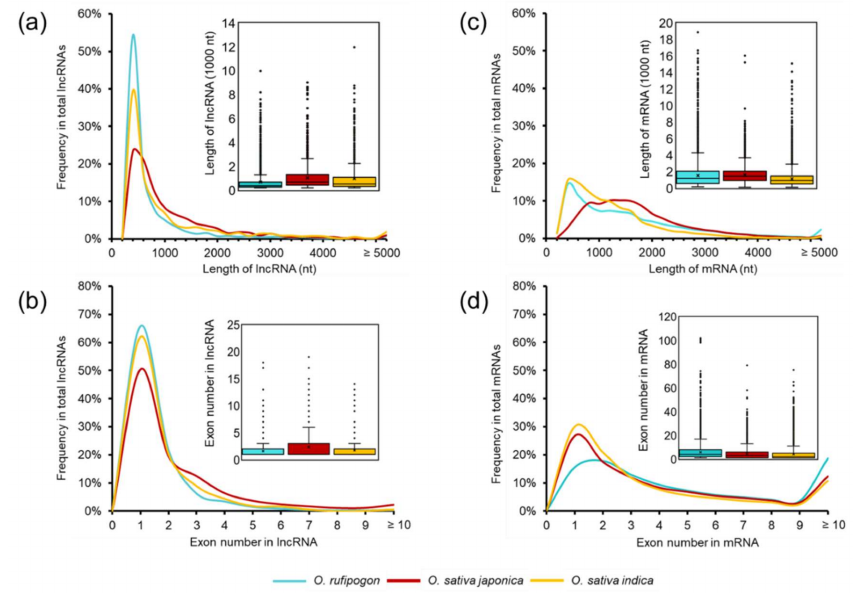
Figure 2. Frequency distribution comparisons of lncRNAs and mRNAs between wild and cultivated rice. ( a ) The length of lncRNAs. ( b ) The exon number of lncRNAs. ( c ) The length of mRNAs. ( d ) The exon number of